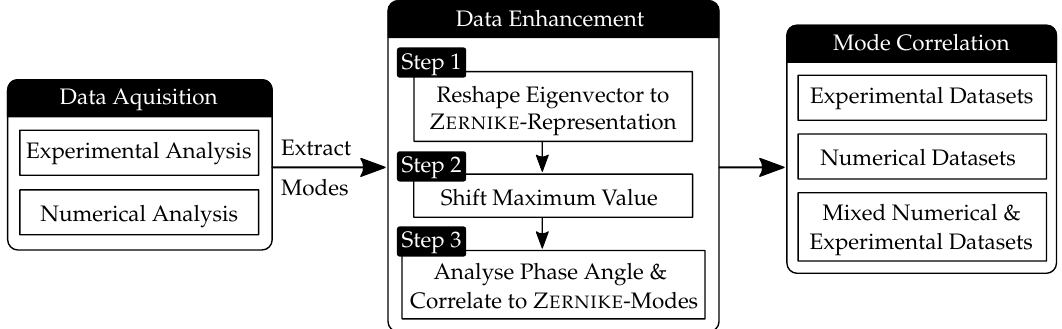
Figure 2. Flowchart of the data extraction and processing, showing the essential methods to improve mode shape